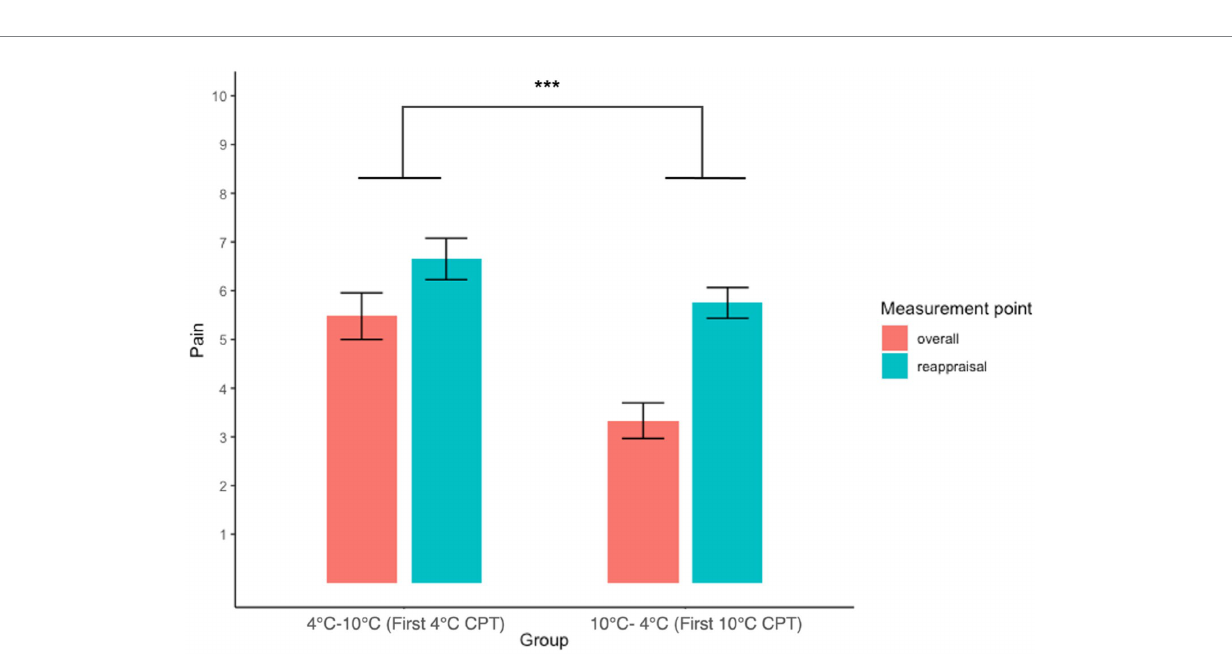
FIGURE 4 Interaction plot of overall and reappraisal with pain intensity between groups. The result of the 4 ° C–10 ° C group depicts the NRS score for the first 4 ° C CPT, and the 10 ° C–4 ° C group depicts the NRS score for the first 10 CPT. Error bars represent the standard error of the